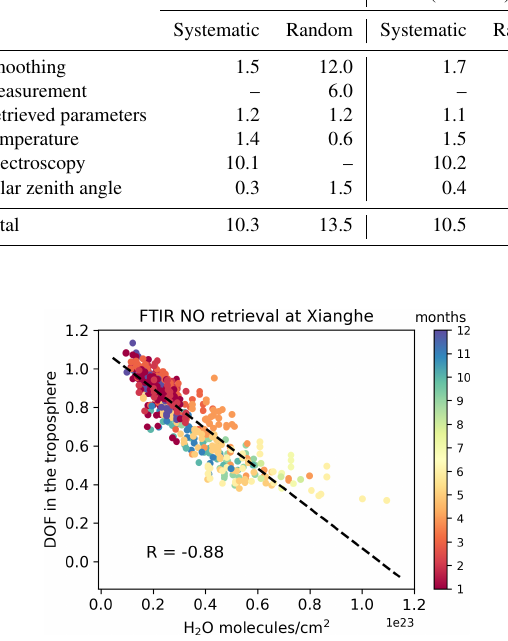
Figure 5. The scatterplots between the DOF in the troposphere and the H 2 O total columns from the NCEP data, colored with the mea- surement month. The dashed black line is the linear fit, and R is the correlation